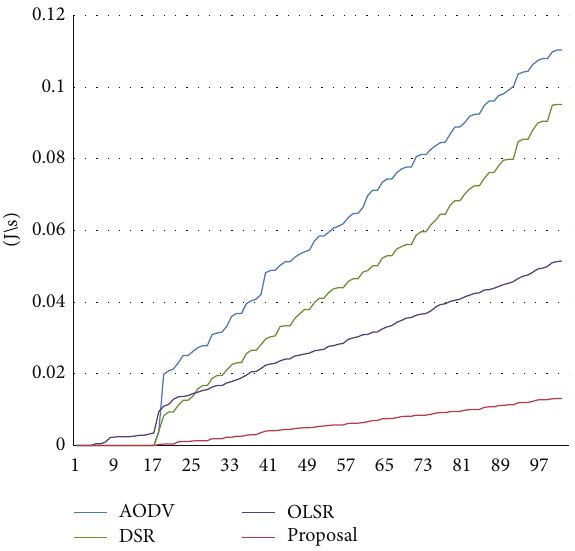
Figure 13: Comparison of energy